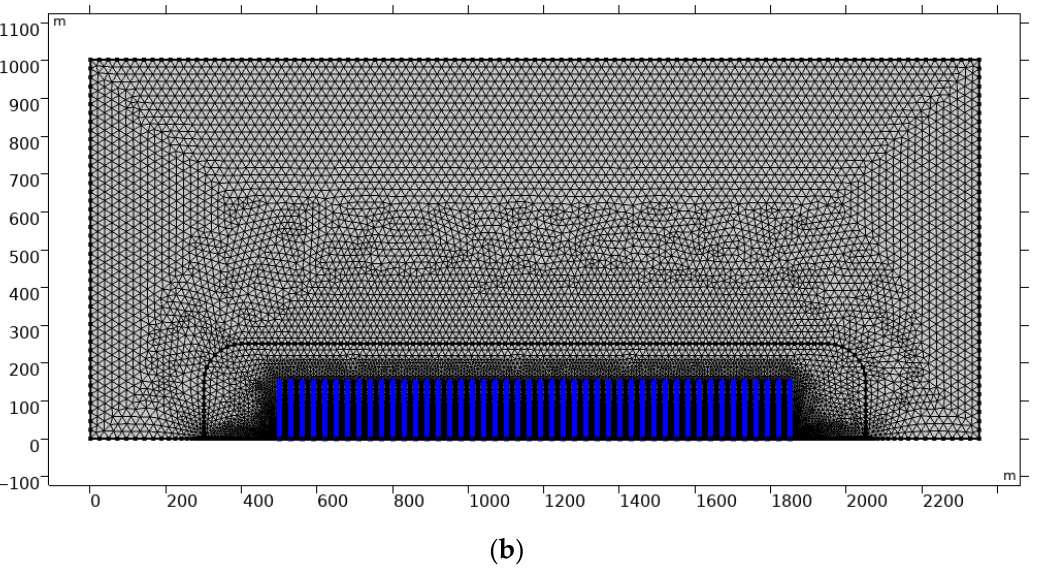
Figure 4. The illustration of the geometry and mesh generation for the simulation model. ( a ) The diagram of the half ‐ geometry for the simulation model (2 ‐ D plan view). ( b )The diagram of the half ‐ geometry for the simulation model (2 ‐ D plan view). Table 2. Parameters for the simulation model of a multistage fracturing horizontal well in a shale oil